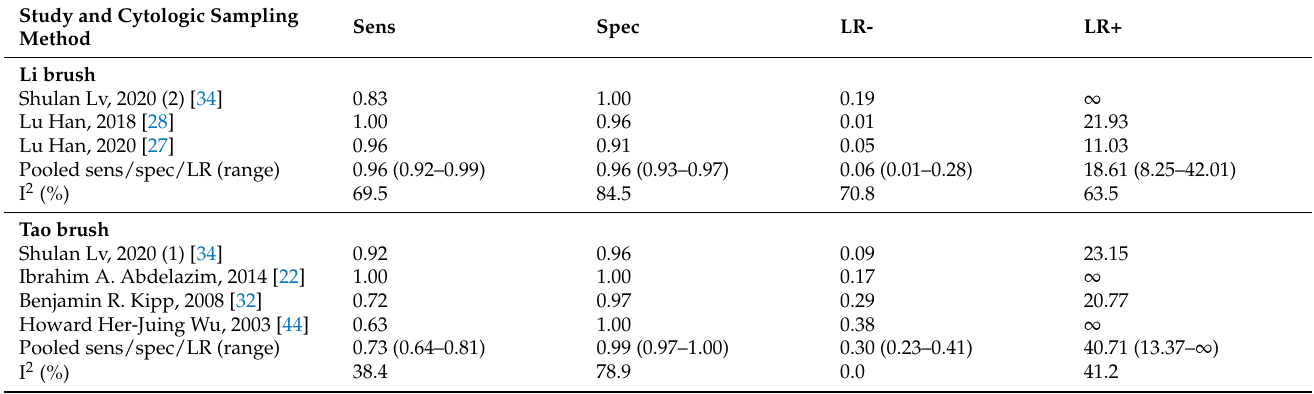
Table 3. Diagnostic accuracy of ECT with different cytologic sampling methods.